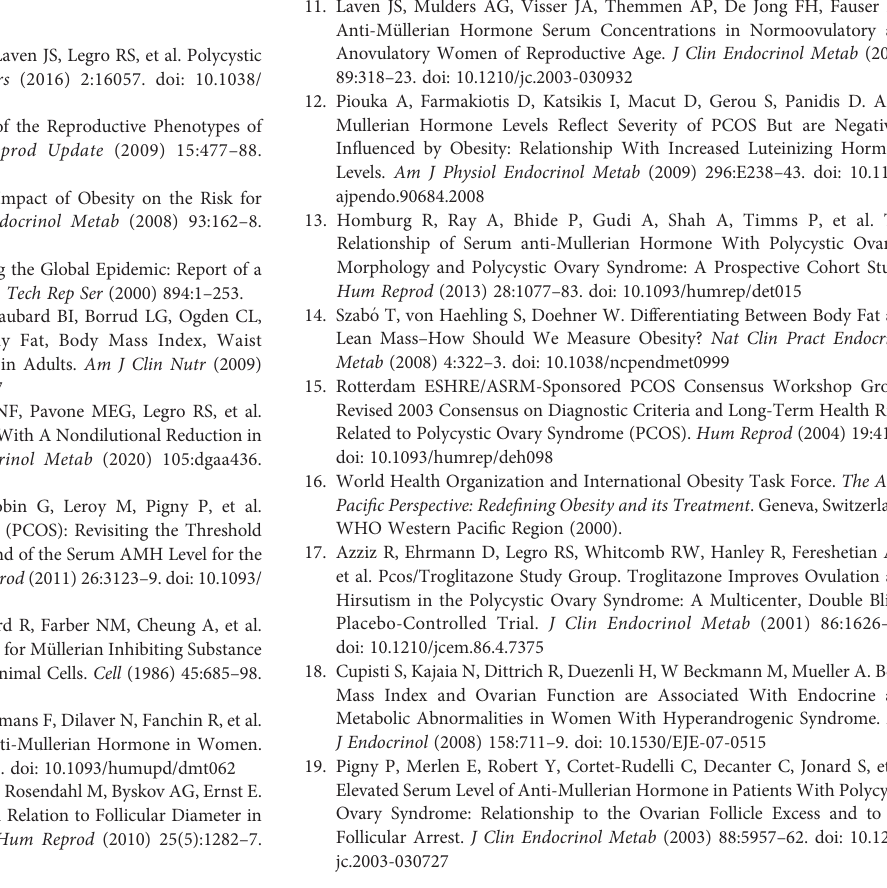
Supplementary Table 1 | Characteristics of the study participants. BMI, body mass index; BFP, body fat percentage; AMH, anti-Müllerian hormone; Total T, total testosterone; Free T, free testosterone; DHEAS, dehydroepiandrosterone sulfate; SHBG, sex hormone-binding globulin; LH, luteinizing hormone; FSH, follicle- stimulating hormone; TSH, thyroid-stimulating hormone; HDL, high-density lipoprotein cholesterol; LDL, low-density lipoprotein cholesterol; FPG, fasting plasma glucose; FSI, fasting serum insulin. Mean ± standard deviation or median (interquartilerange)areshown. TheStudent ’ sttestwasused fornormaldistribution data and the Mann – Whitney U test was used for non-normal distribution